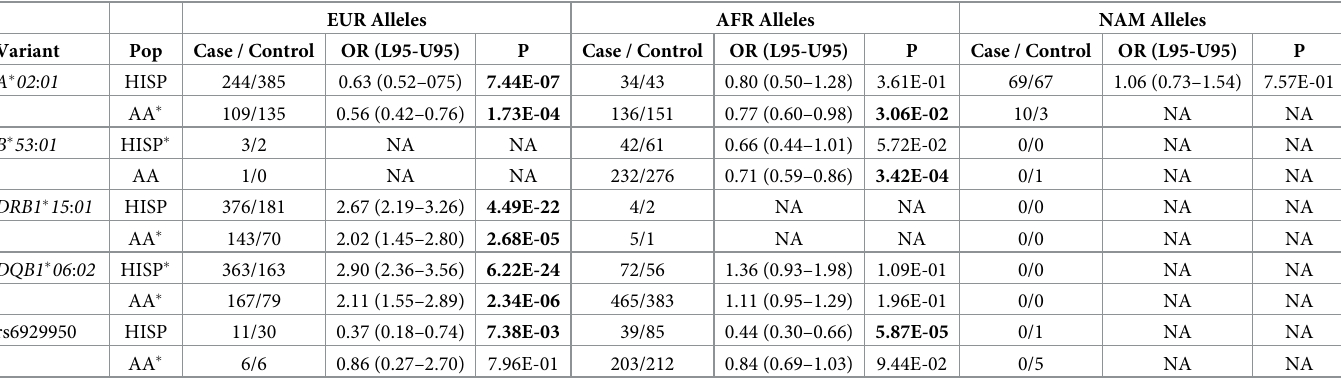
Table 5. Local ancestry stratification.